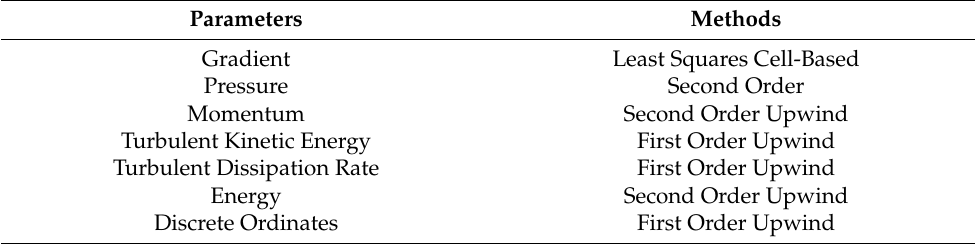
Table 2. Spatial discretization. Parameters Methods